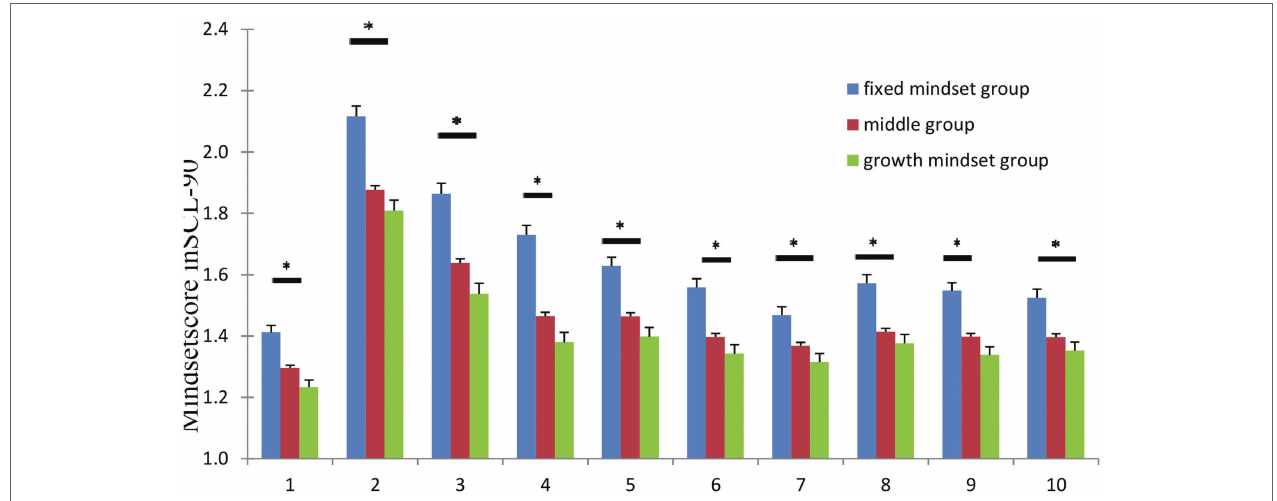
FIGURE 2 | Mean score of subscale of SCL-90 in different groups with error bars representing standard error of the mean and asterisks representing significant difference among groups.